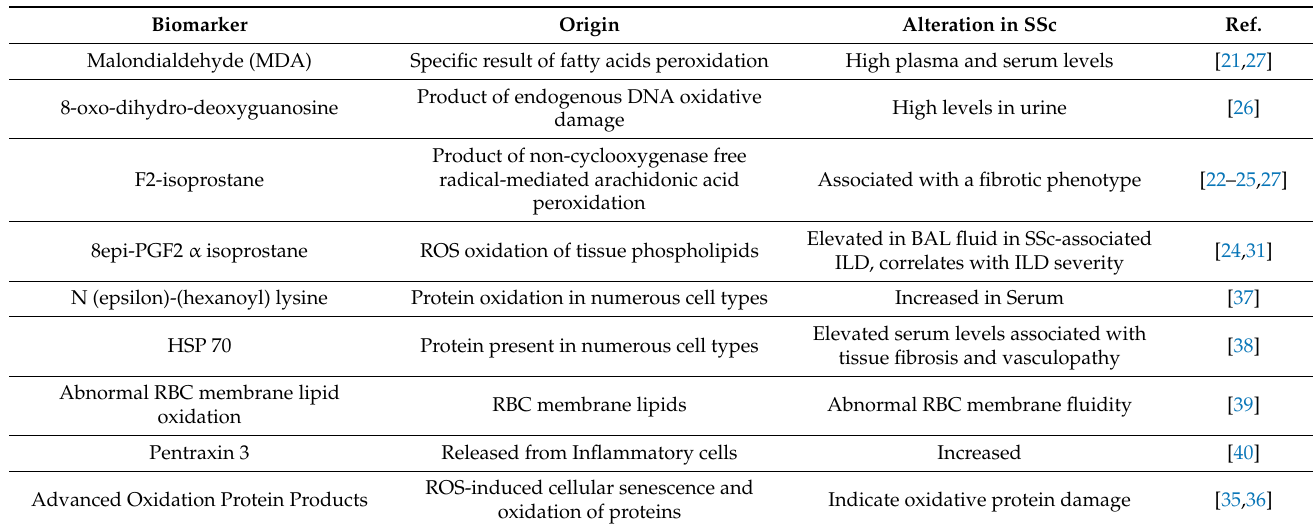
Table 1. Biomarkers of Oxidative Stress in Systemic